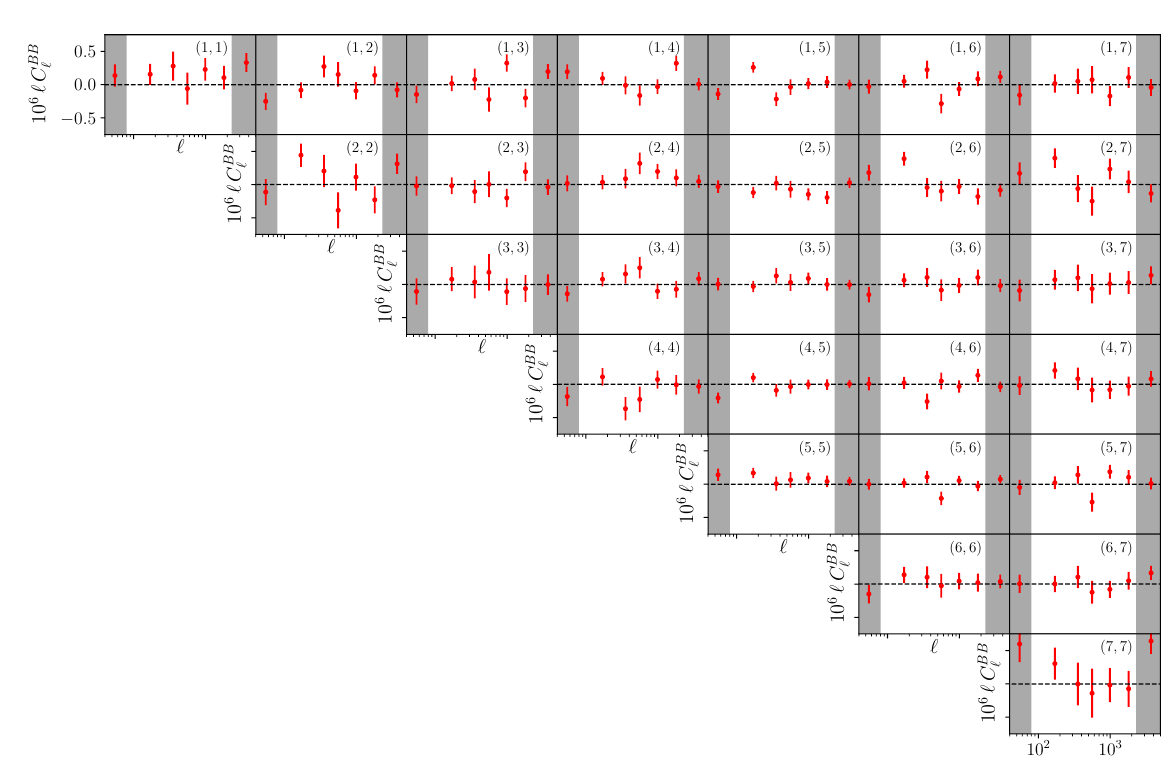
Figure 6. Same as Fig. 5 for the B -mode power spectra. Here, the grey areas represent the (cid:96) -bandpowers that were excluded in the analysis, where a detection of B -modes should not be taken into account. We do not find statistically significant B -modes, with a PTE of ∼ 10% for the measurements shown. Gray shaded areas represent (cid:96) -bandpowers that have been discarded in this